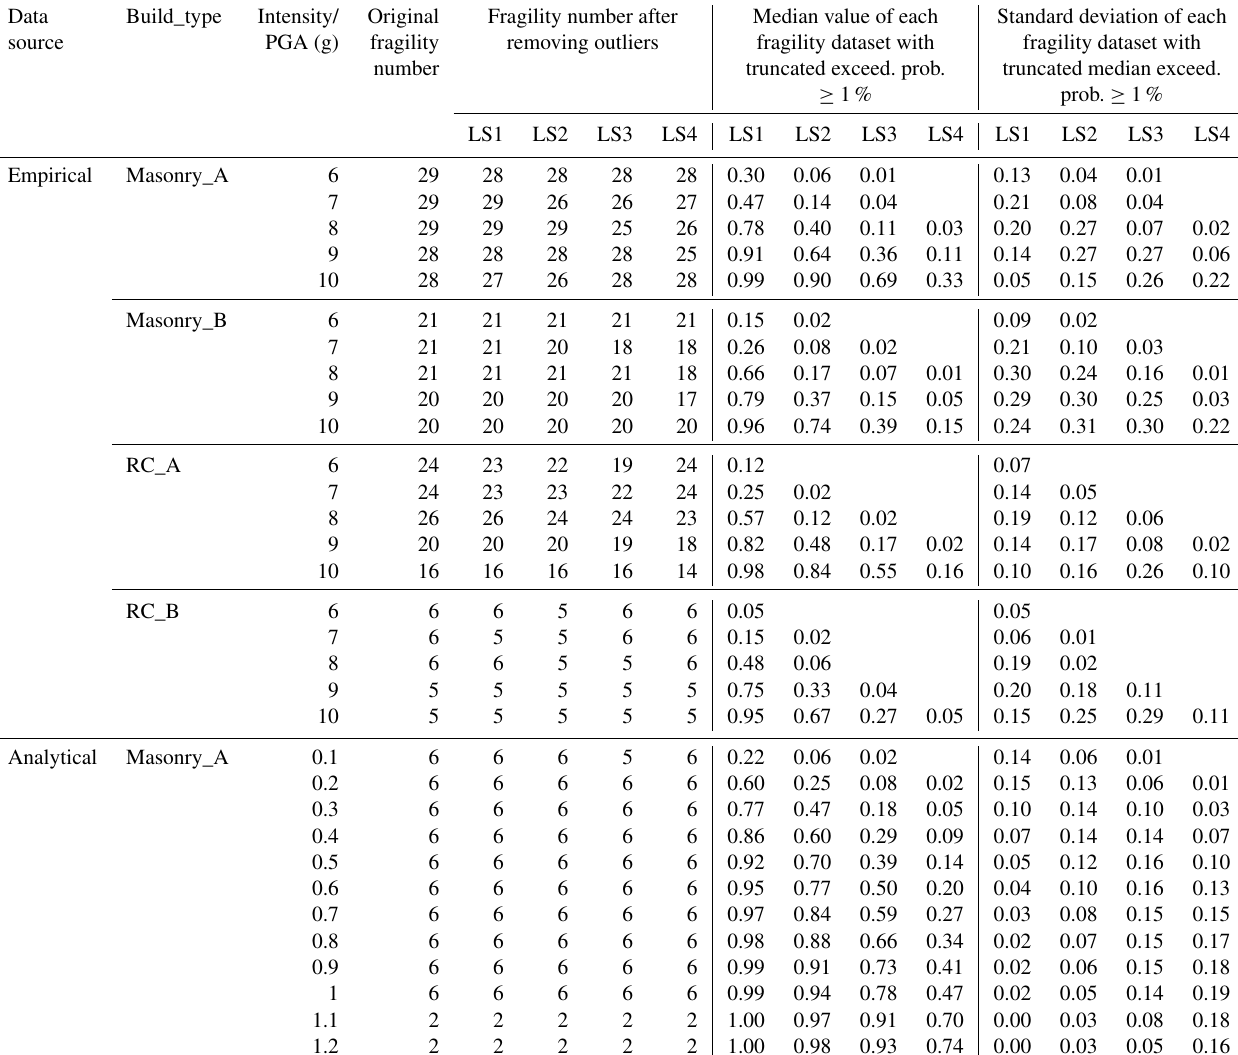
Table B1. Statistics of fragility database for each damage limit state and each building type.